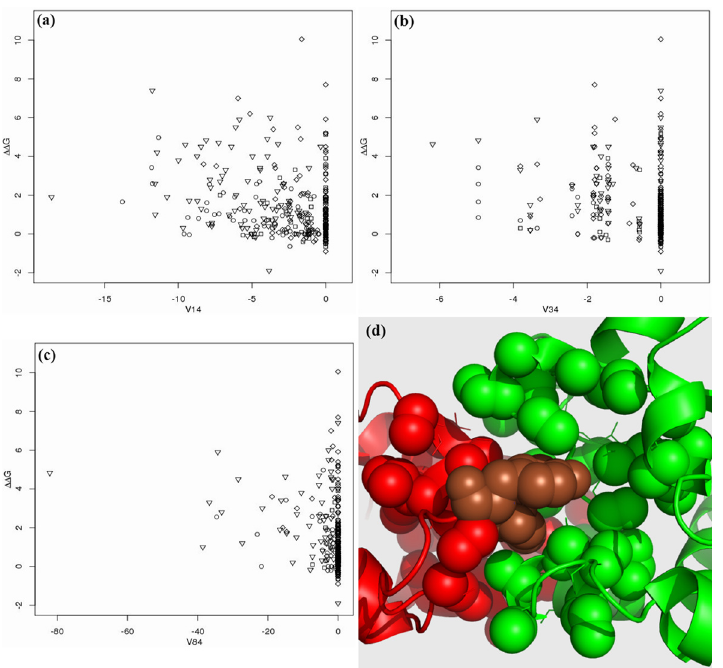
Fig 3. The distribution of top three features V14 (in (a)), V34 (in (b)) and V84 (in (c)). The definitions of V14, V34 and V84 are listed in Table 5. The importance of V14, V34 and V84 is ranked as 1 st , 2 nd and 3 rd , respectively, as shown in Fig 2, while the Pearson correlation coefficients of the three features are -0.315, -0.277 and -0.273, respectively, as shown in Table 5. The y-axes denote ΔΔ G . (cid:7) : ILE, VAL, LEU, MET, ALA and GLY; ◻ : CYS, THR, SER, PRO, HIS, GLN and ASN; ♢ : GLU, ASP, LYS and ARG; ! : PHE, TRP and TYR. (d) shows an example of the neighborhood of the two mutations (in brown): Tyr54 and Tyr55 of Chain A (in red) in 1BXI together with the partner protein (Chain B in green). All carbon atoms in the neighborhood which have no covalent bond with any oxygen or nitrogen are shown in ‘ sphere ’ view. The alanine mutation of Tyr54 has ΔΔ G = 4.83kcal/mol with the smallest value of V84, and that of Tyr55 has ΔΔ G = 4.63kcal/mol with the smallest value of